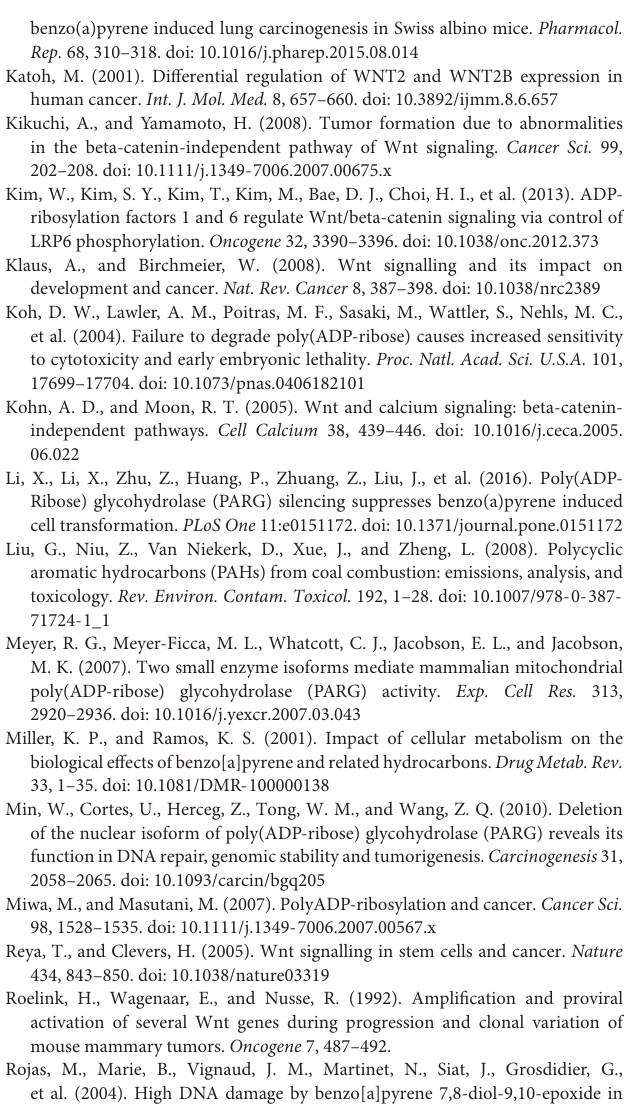
TABLE S1 | Primers used for real-time quantitative